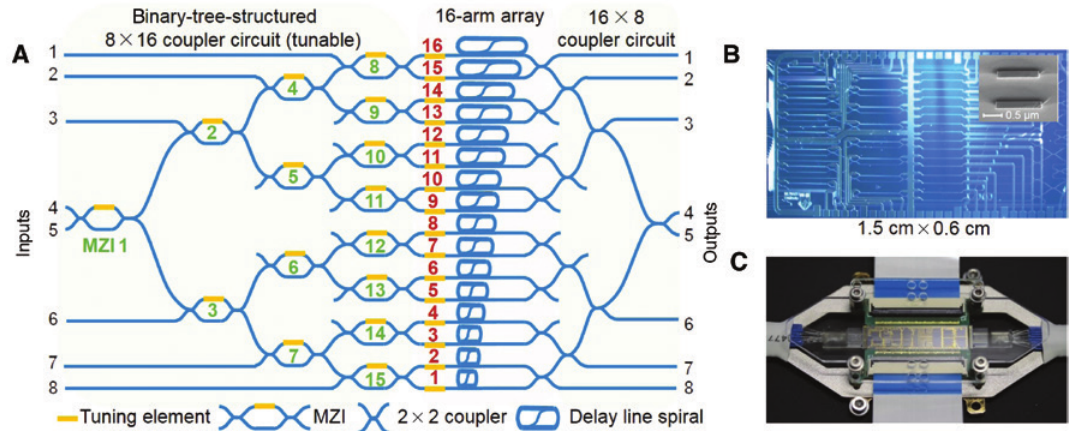
Figure 1: (A) Schematic of the 16-arm tapped delay line filter; (B) fabricated device (inset: cross section of the waveguide structure); (C) packaged